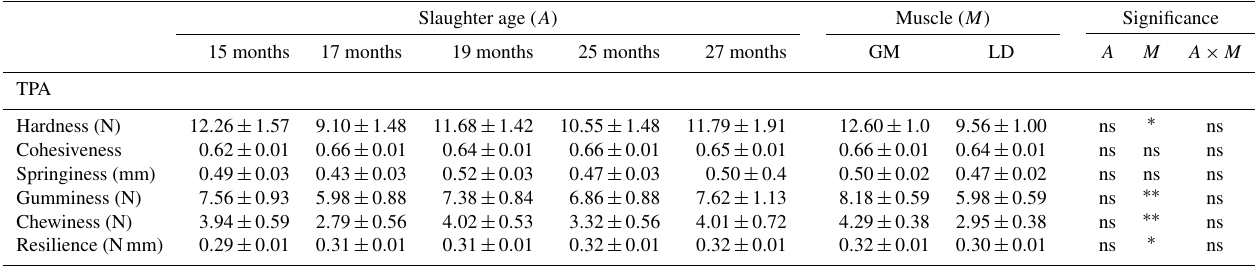
Table 3. Effect of slaughter age and muscle type on texture of meat (mean ±